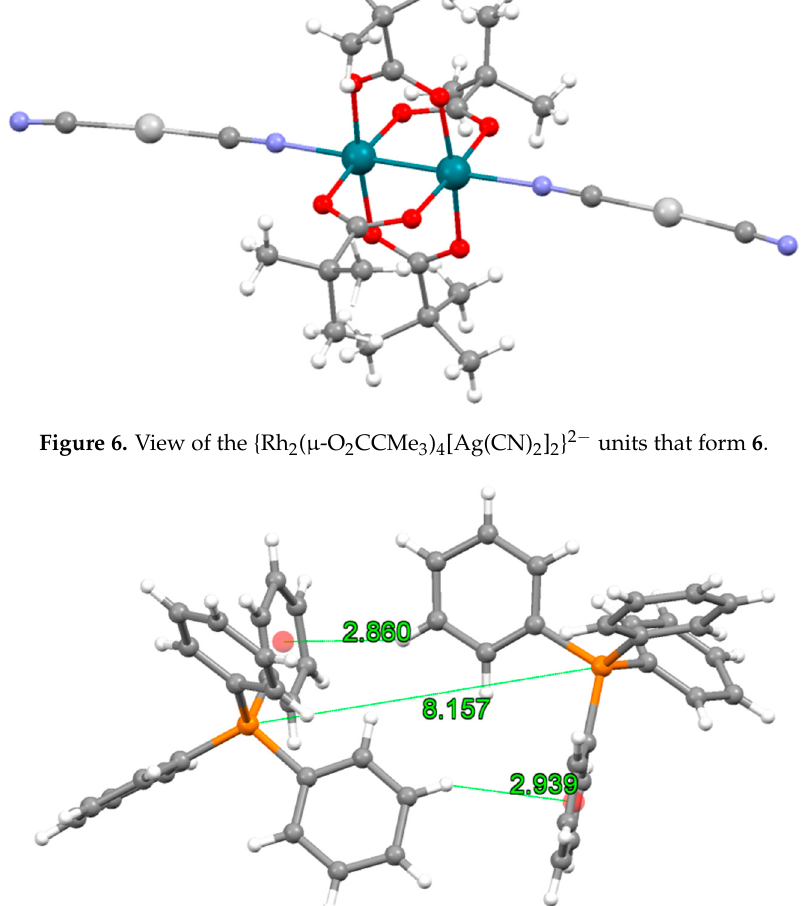
that form 5 along the direction of the Rh-Rh bond. Figure S7: Representation of the structure of 4 along the